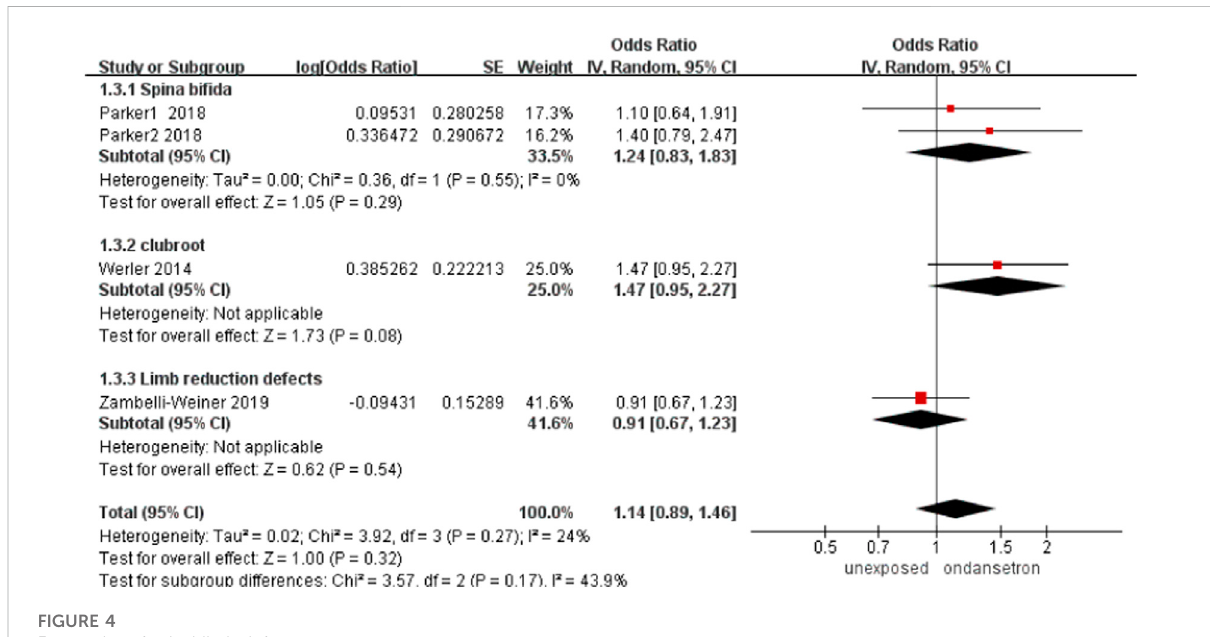
FIGURE 4 Forest plot of spinal limb defects.